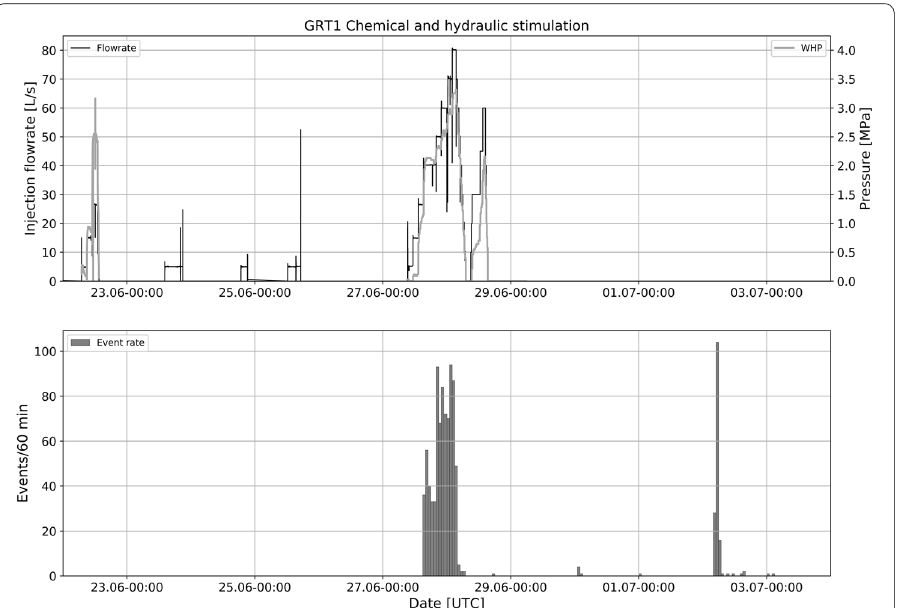
Fig. 9 GRT-1 pre-stimulation test, chemical and hydraulic stimulations. Injection flow rate and wellhead pressure (top) in parallel with the seismic rate per hour and local magnitude